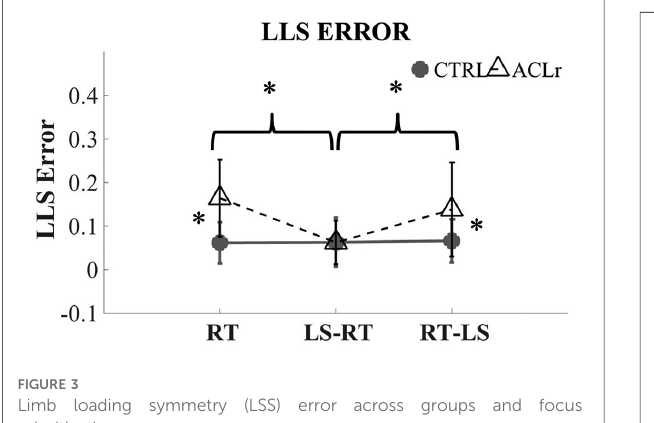
FIGURE 3 Limb loading symmetry (LSS) error across groups and focus prioritizations.